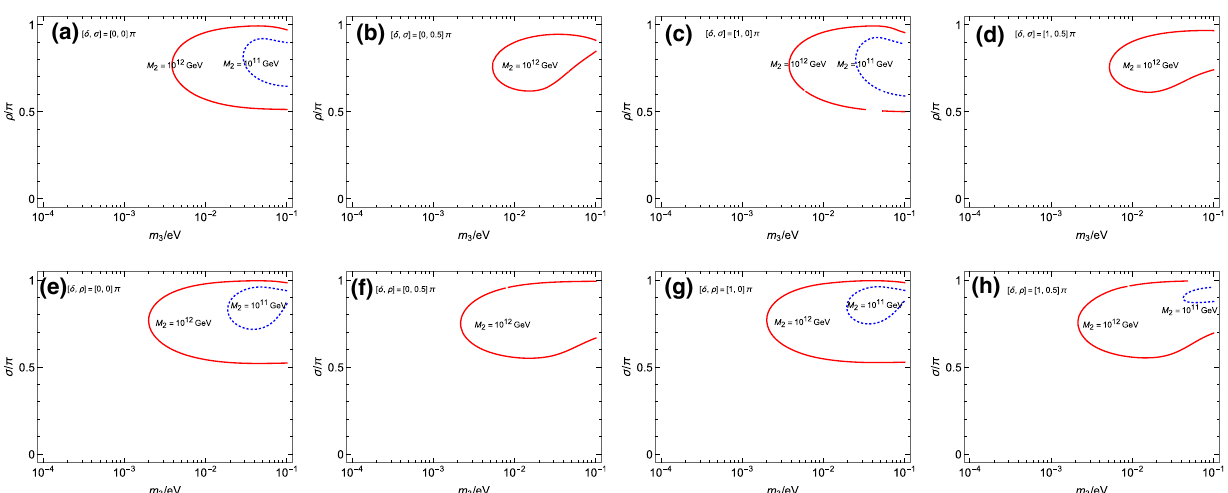
Fig. 7 First row: in the scenario of M D being the triangluar matrix and IO case, for the various trivial-value combinations of [ δ,σ ] and some benchmark values of M 2 (see the labels for the plotted lines), the val-